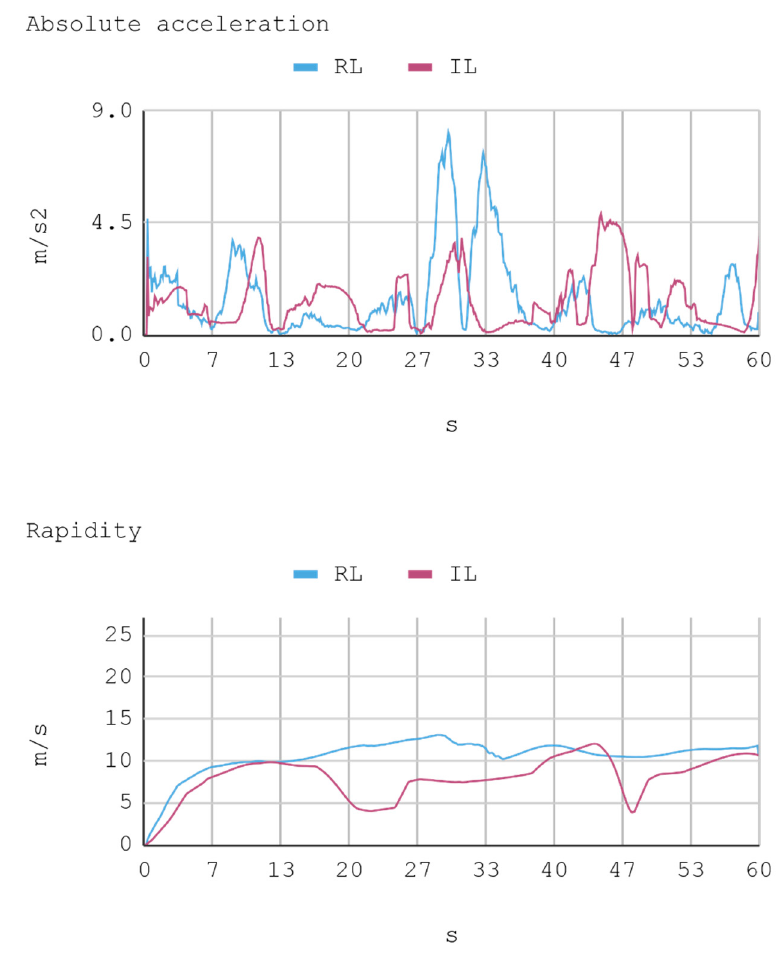
Figure 15. Case 2. Automobile’s absolute acceleration and rapidity.